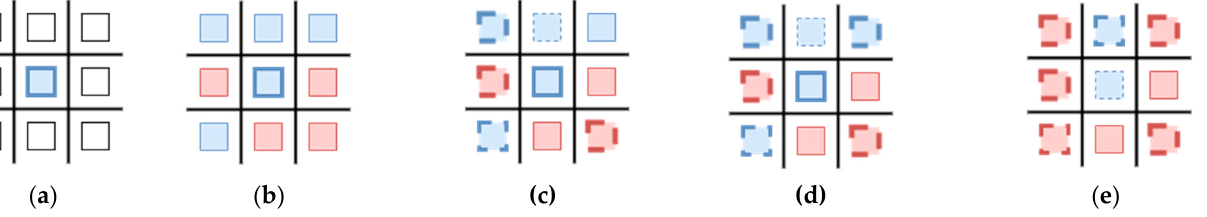
Figure 3. ( a ) General setup, ( b ) Blue and red cells represent subscription to firms i and j , respectively. ( c ) Different types of cell borders denote varying degrees of inertia (details below). ( d ) Price competition at p i > p j and ( e ) resulting changes in consumer inertia and subscription due to neighborhood interaction effect.